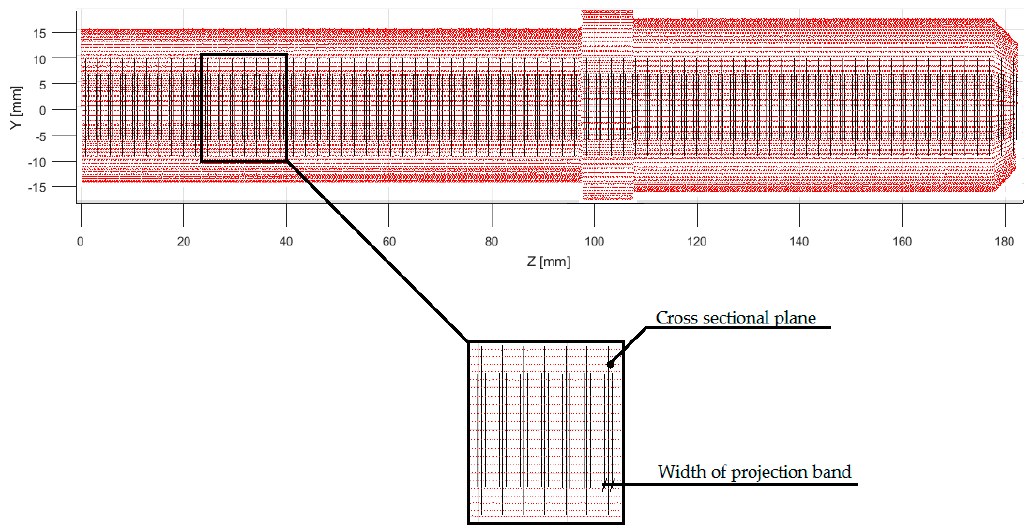
Figure 5. Span vector of cross-section planes with marked projection bands.